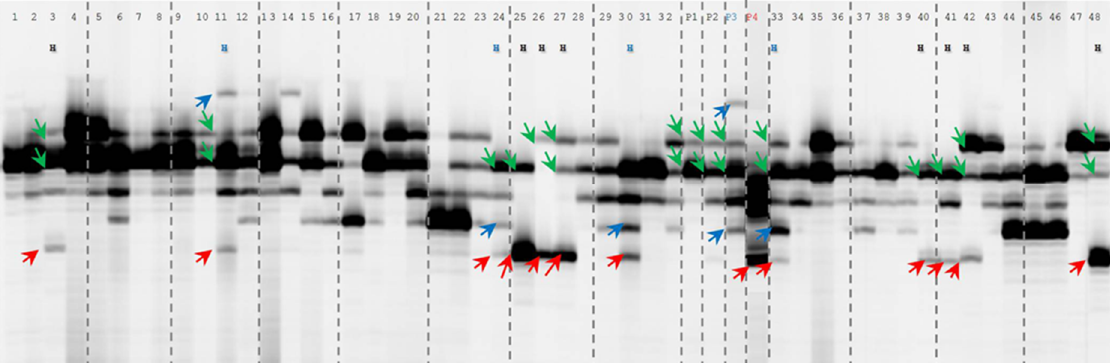
Figure 3. Marker-assisted selection of F 1 hybrids from the crosses of L. hansonii × L. brownii var. colchesteri using the L9 SSR marker. P1, P2, and P3 indicate three L. hansonii lines used as the female parent and P4 indicates L. brownii var. colchesteri used as the male parent. The letter “H” indicates F 1 hybrids from the cross between L. hansonii × L. brownii var. colchesteri . Green arrows indicate common alleles found in three L. hansonii lines (P1, P2, and P3). Blue arrows indicate specific alleles found in P3 L. hansonii . Red arrows represent a specific allele in L. brownii var. colchesteri , P4.